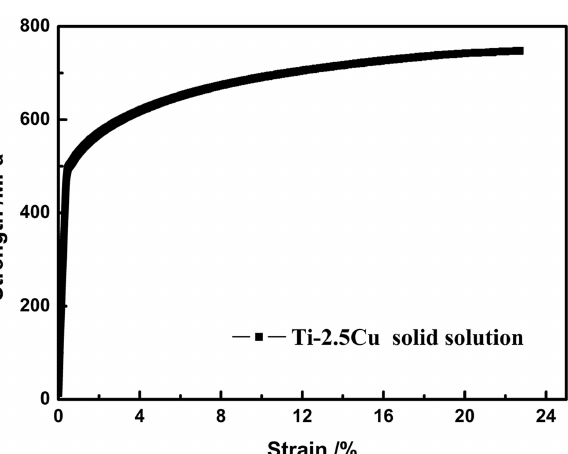
Figure 2: Bright field TEM images of Ti-2.5Cu alloy after duplex aging with the prestrain of (a) 10% and (b) 20%.